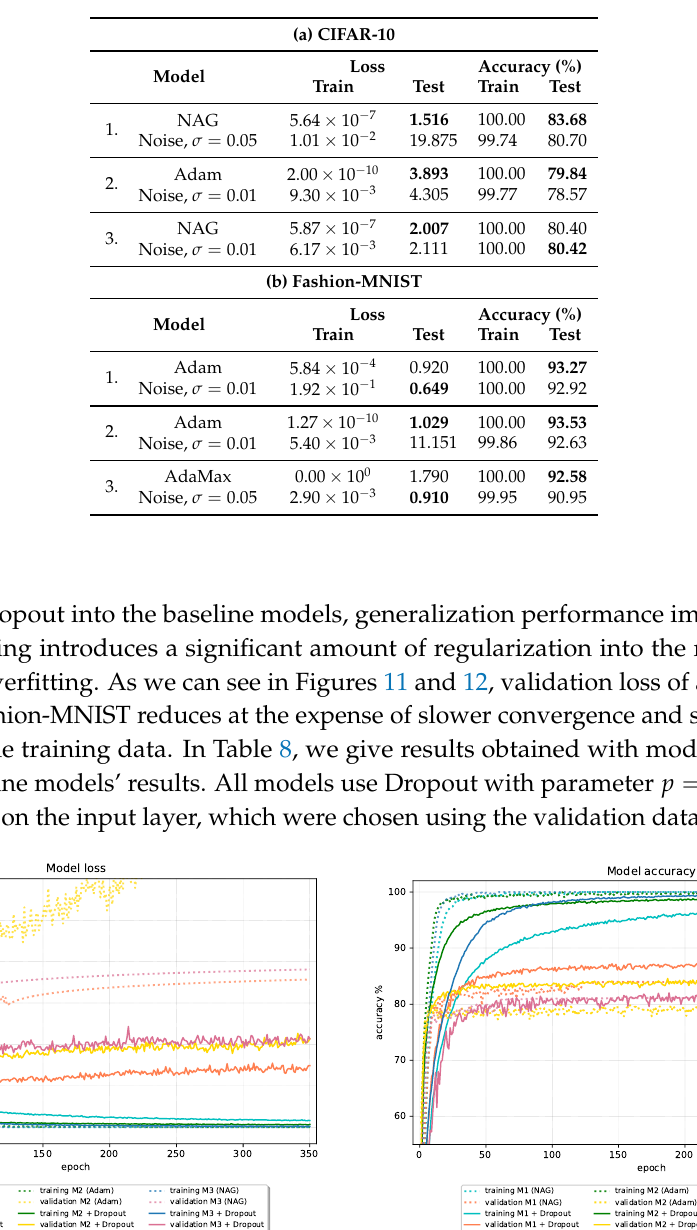
Figure 10. Images with different amounts of added noise. Table 7. Results of adding Gaussian noise into the baseline models.